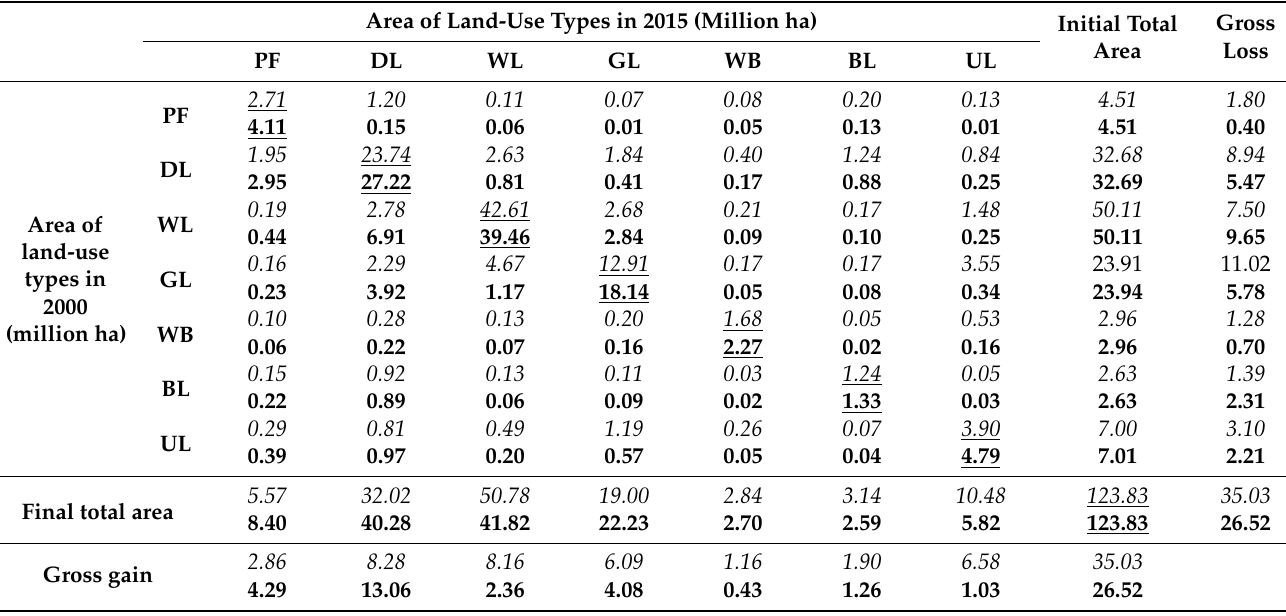
Figure 4. Land-use data of visual interpretation ( a ) and simulated land use ( b ) in 2015. Table 3. Transition area of land-use types from 2000 to 2015.